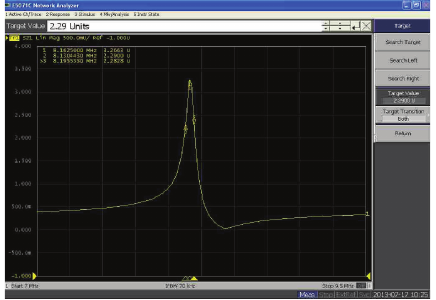
Figure 8: The test result of STC antenna.